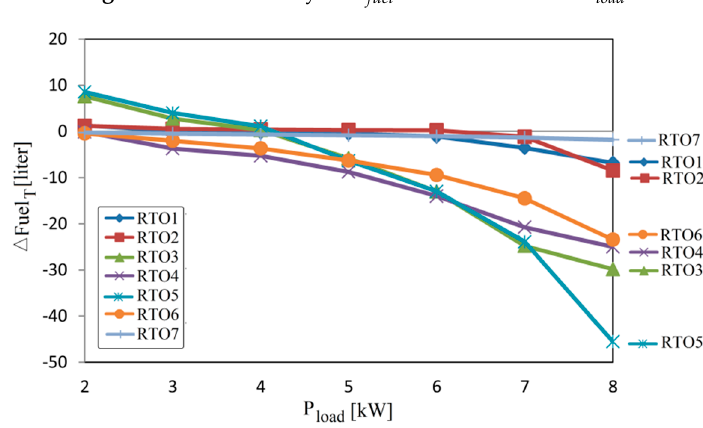
= 25 and di ff erent P load .